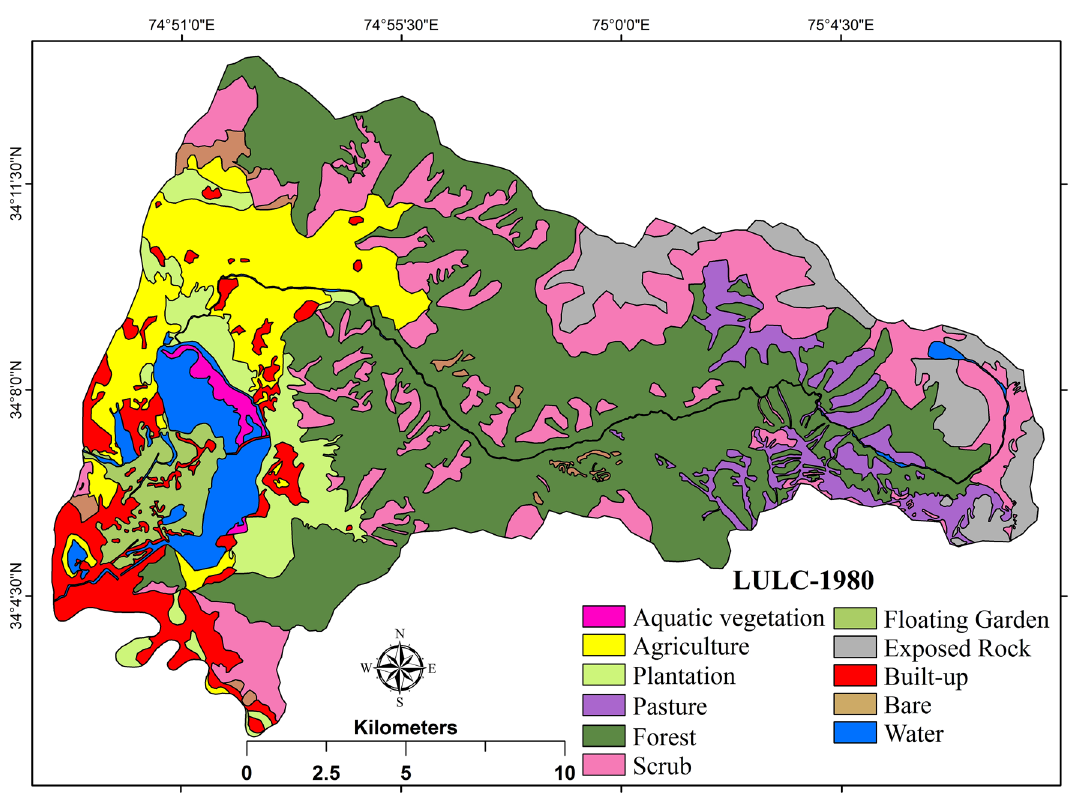
Fig. 3 LULC map of